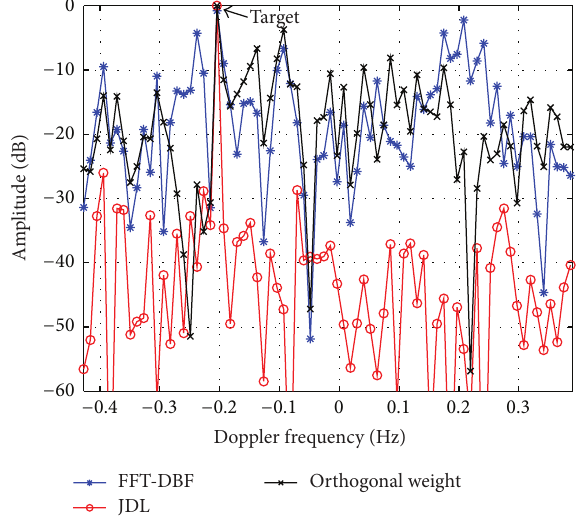
Figure 9: Compared Doppler results (real sea clutter, target azimuth 130 ∘ ).